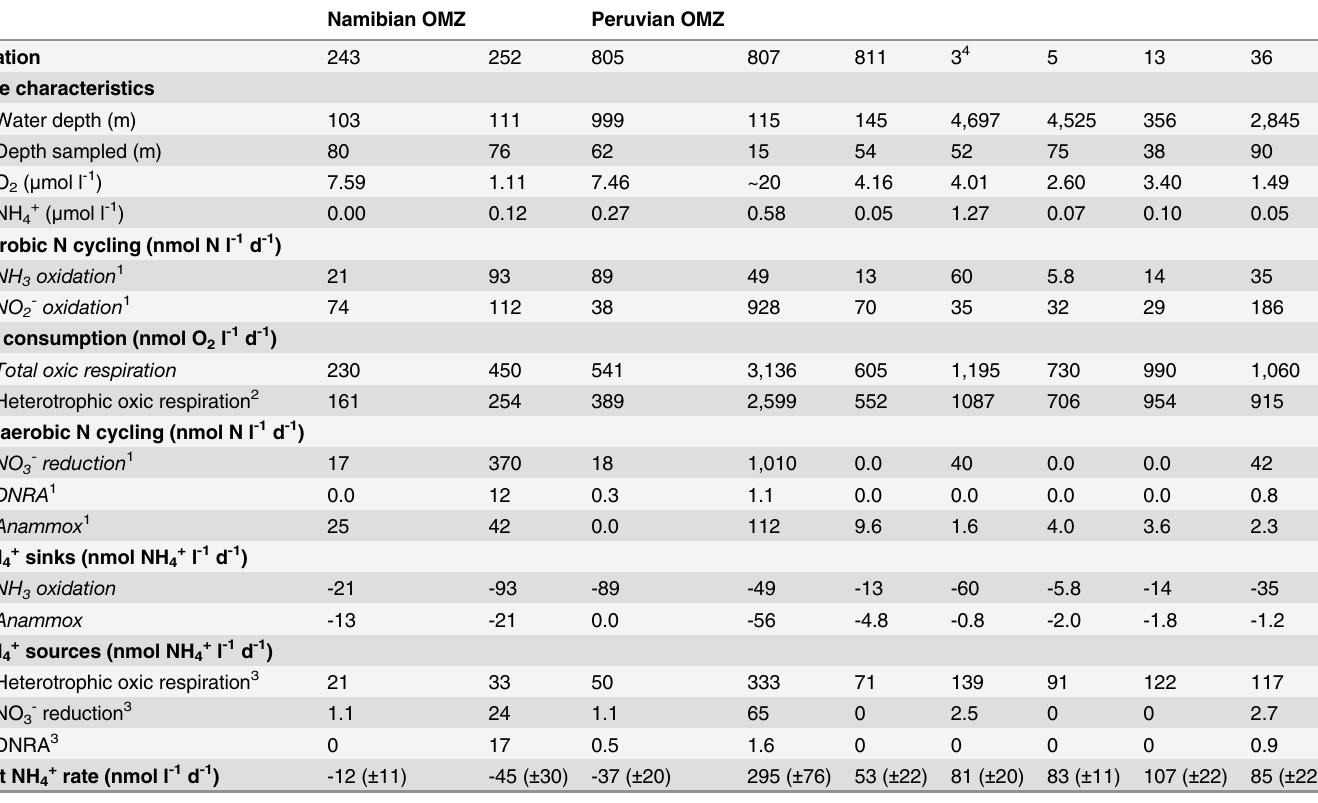
Table 2. Ammonium budget for the upper Namibian and Peruvian OMZ considering aerobic and anaerobic NH 4+ -producing and consuming pro- cesses. For the sake of clarity, standard errors for the individual processes determined at each station are not listed here (typically ~10% of the measured rate). Directly measured rates are in italics, the remainder were inferred from idealized stoichiometries (see S1 File for further details). Liberation of NH 4+ from organic matter via oxic as well as NO 3- respiration accounts for bacterial N-uptake assuming a growth efficiency of 0.15 [66] and a C/N ratio of 6.6 for the het- erotrophic community